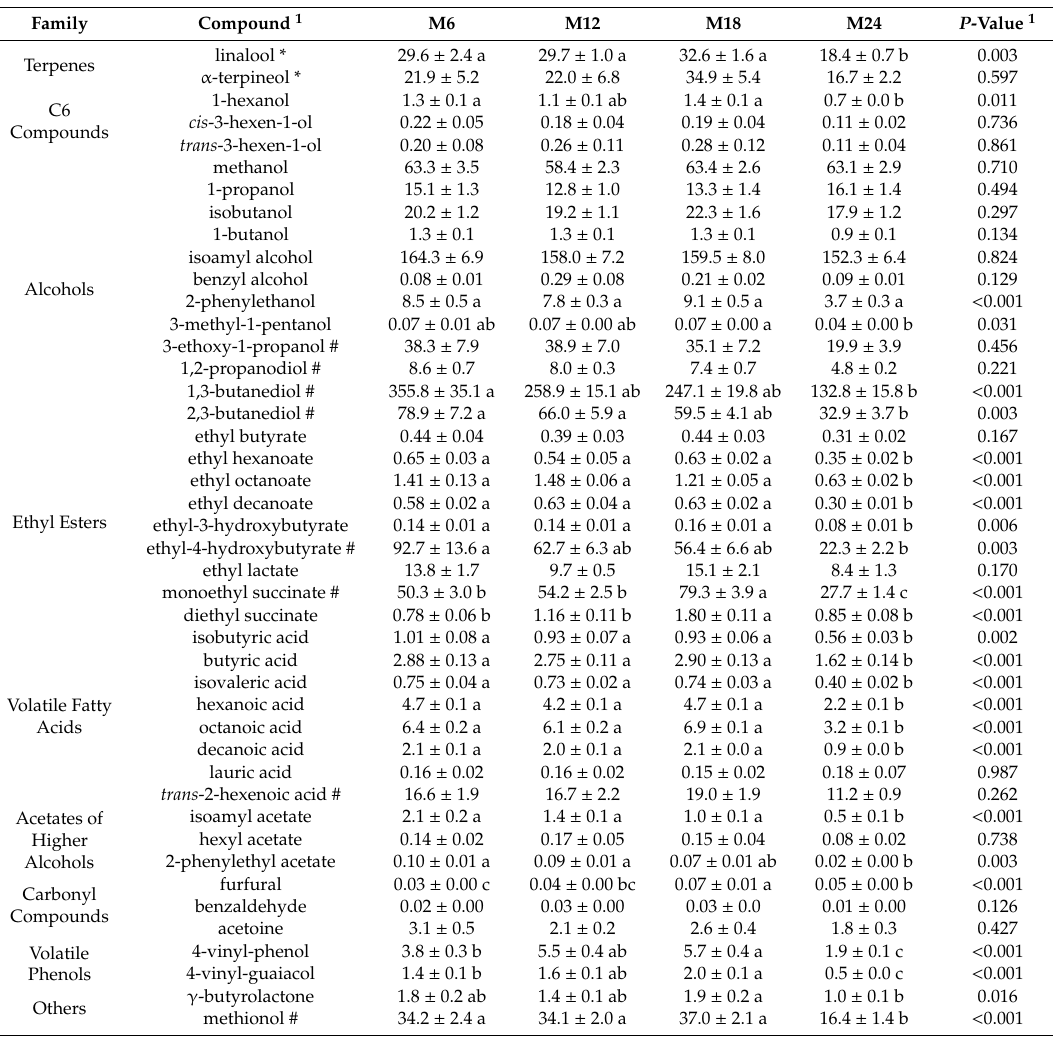
Table 2. Average concentrations of volatile compounds (mean ± standard error) in Treixadura wines from the Ribeiro Designation of Origin (DO) at di ff erent times of bottle aging. M6, M12, M18, and M24 indicate 6, 12, 18, and 24 months after